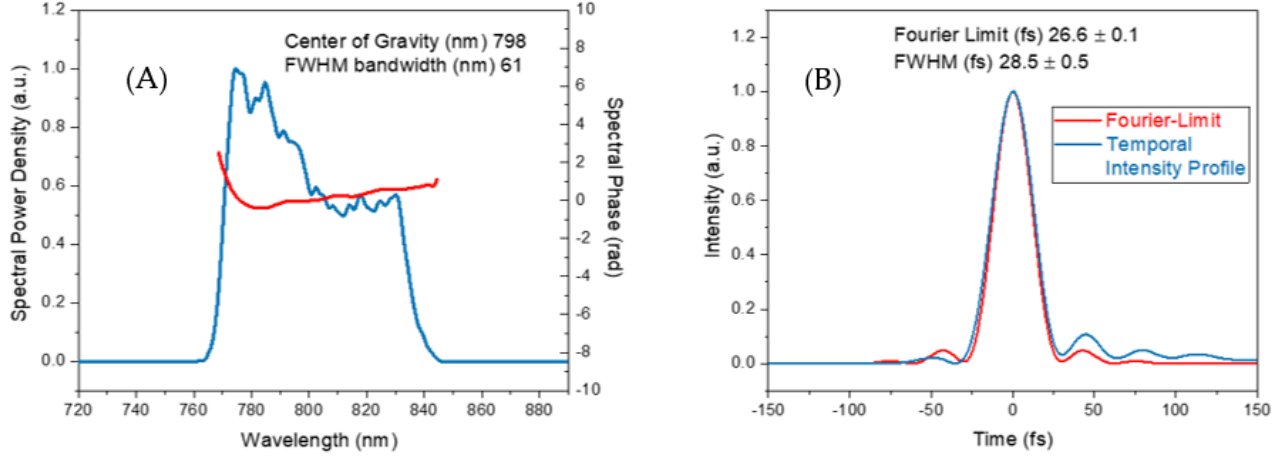
Figure 8. ( A ) Spectral intensity and spectral phase and ( B ) transform limited and temporal pulse shape of L3 measured at the ELIMAIA Beamline.